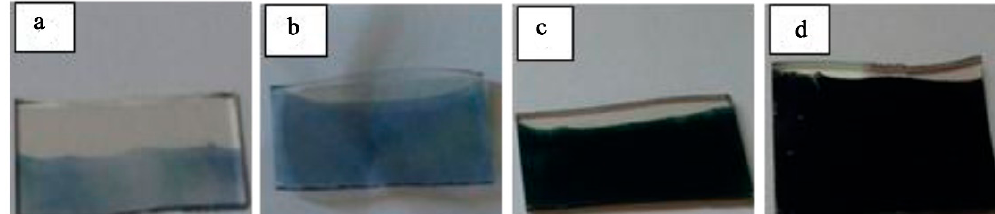
Figure 7. Di ff erent color states of PANI films at di ff erent numbers of deposition cycles: ( a ) 5, ( b ) 10, Figure 7. Different color states of PANI films at different numbers of deposition cycles: ( a ) 5, ( b ) 10, ( c ) 20, and ( d ) 30 cycles. Coatings 2019 , 9 , x FOR PEER REVIEW ( c ) 20, and ( d ) 30 cycles.